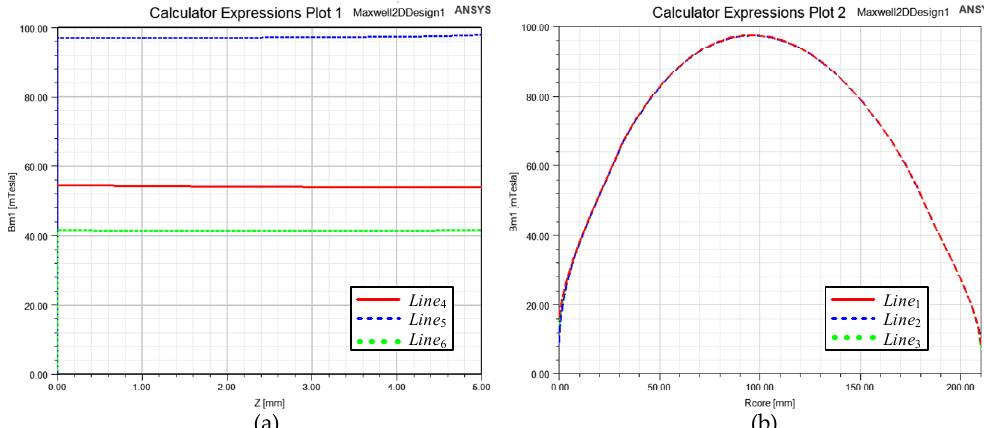
Figure 3. The distribution of magnetic flux density inside the transmitter core. ( a ) The distribution of magnetic flux density versus R-axis; ( b ) The distribution of magnetic flux density versus Z-axis.